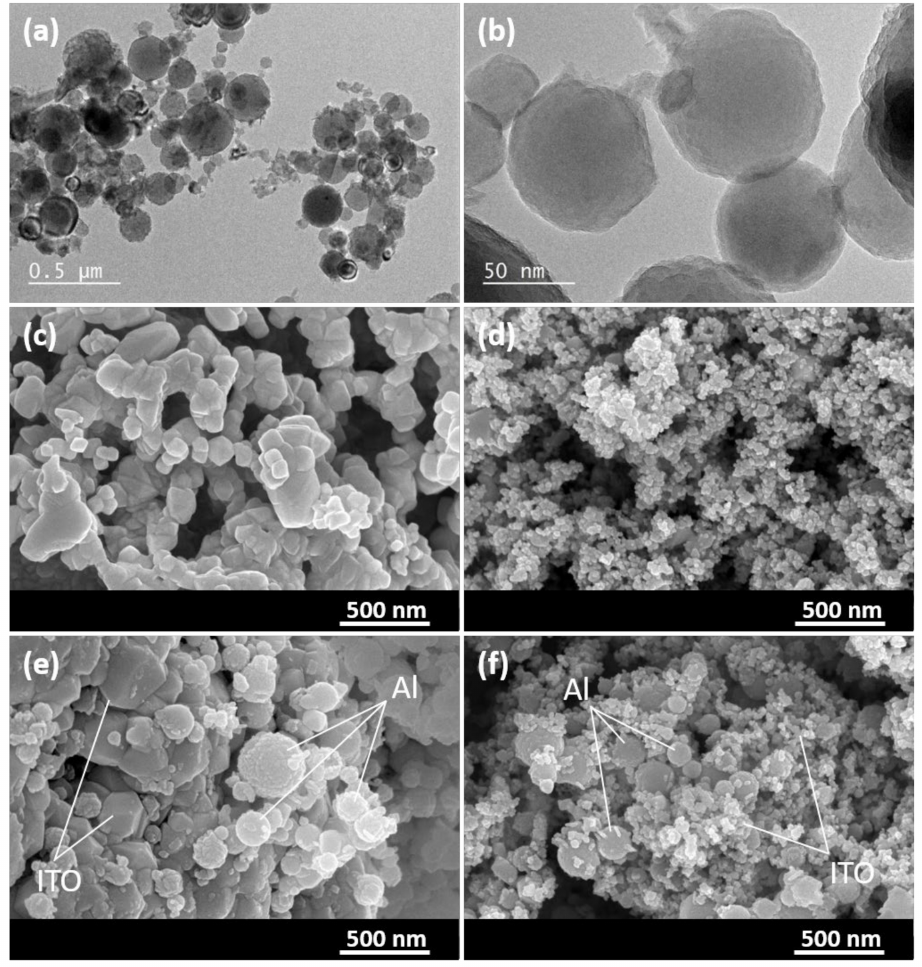
Figure 1. TEM pictures ( a , b ) of Al nanopowder and SEM images ( c – f ) of ITO_ µ m, ITO_nm, Al/ITO_ µ m, and Al/ITO_nm materials, respectively.